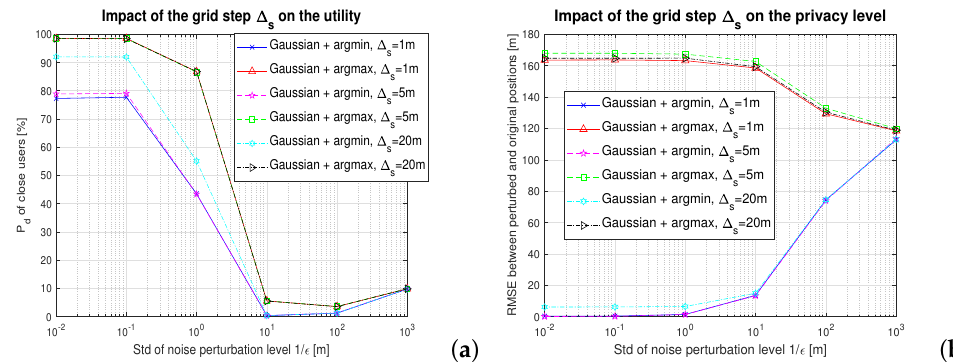
Figure 14. The impact of the grid step on the ( a ) utility and ( b ) privacy. A proximity service with γ = 2 m.